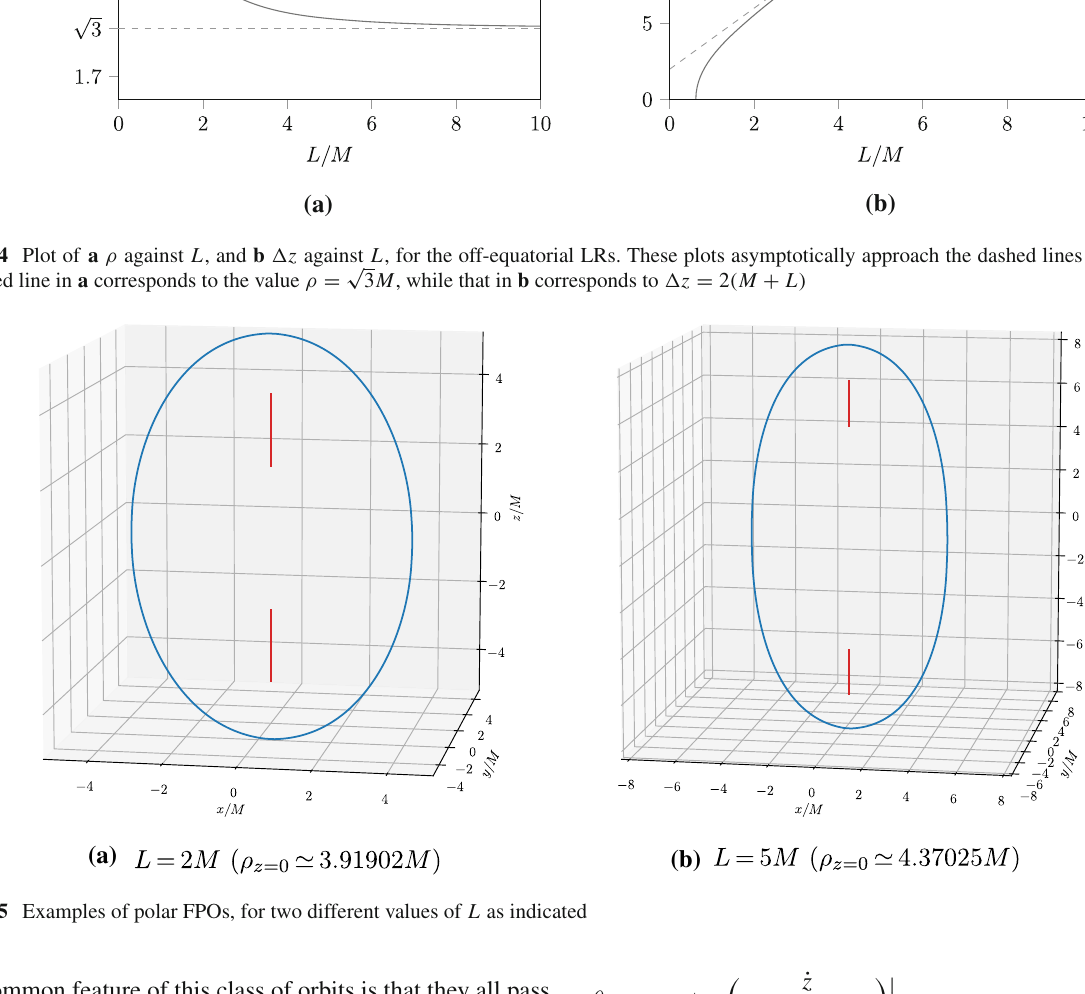
A common feature of this class of orbits is that they all pass through the equatorial plane z = 0, with the property that = 0. It turns out that a possible choice of parameter ˙ ρ | z = 0 for these orbits is the radius ρ of the orbit when it passes through the equatorial plane. As usual, we denote this by ρ z = 0